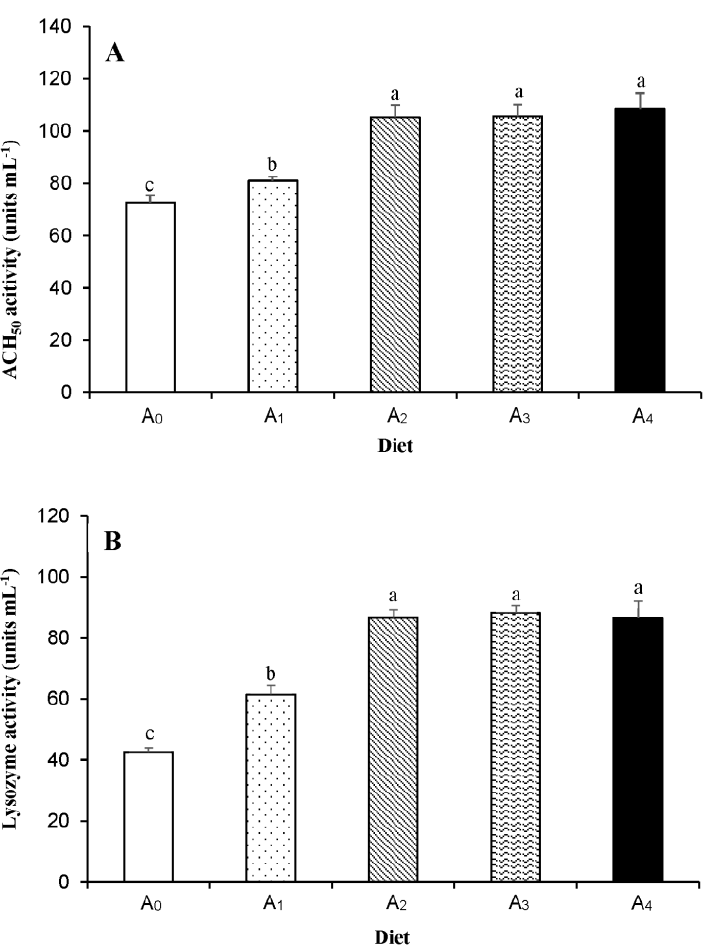
Figure 3. The innate humoral parameters of ACH 50 activity ( A ) and lysozyme activity ( B ) in E. coioides fed the control diet or diets containing Antrodia camphorata (AC) at 0 (A 0 ), 1.5 (A 1 ), 3.0 (A 2 ), 4.5 (A 3 ), and 6.0 (A 4 ) g kg −1 after 28 days of supplementation. See Figure 2 for statistical information.